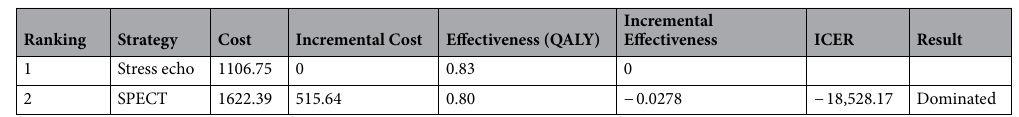
Table 3. Cost effectiveness